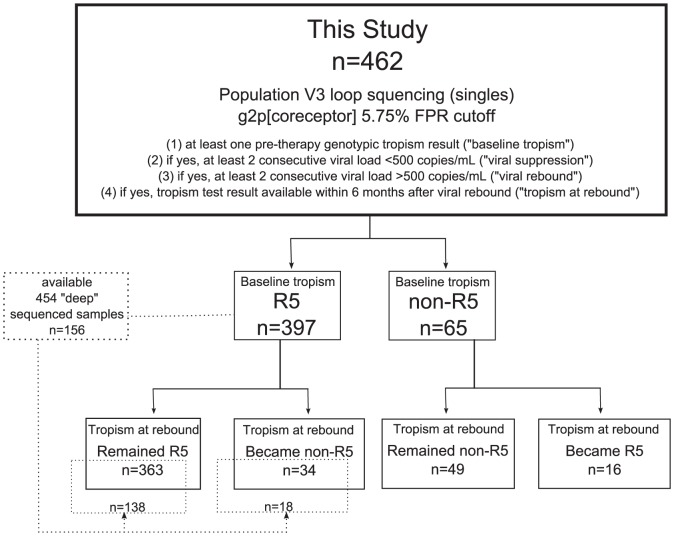
Study flow chart of our primary analysis: Virologic suppression definition: <500 copies/mL; geno2pheno[coreceptor] FPR cutoff 5.75%.